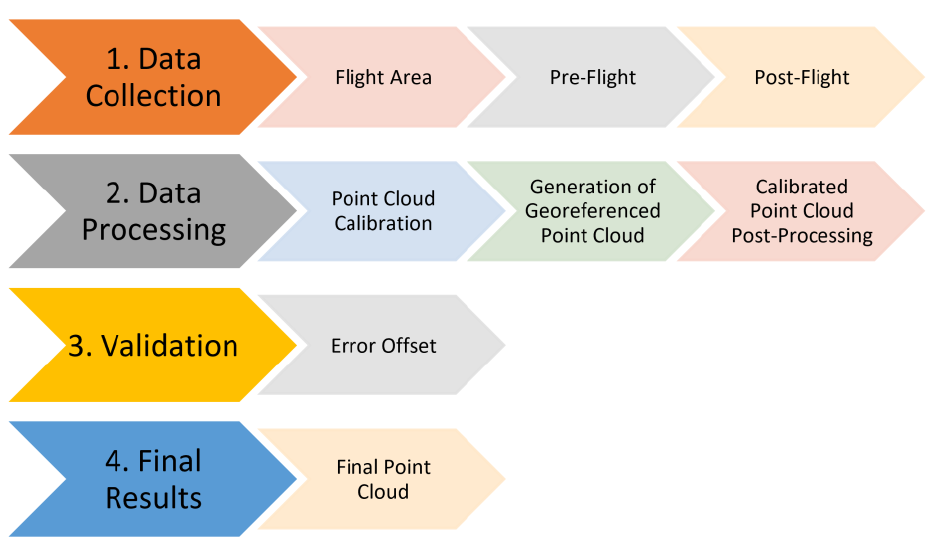
Figure 2. Implementation process flow for the proposed system.